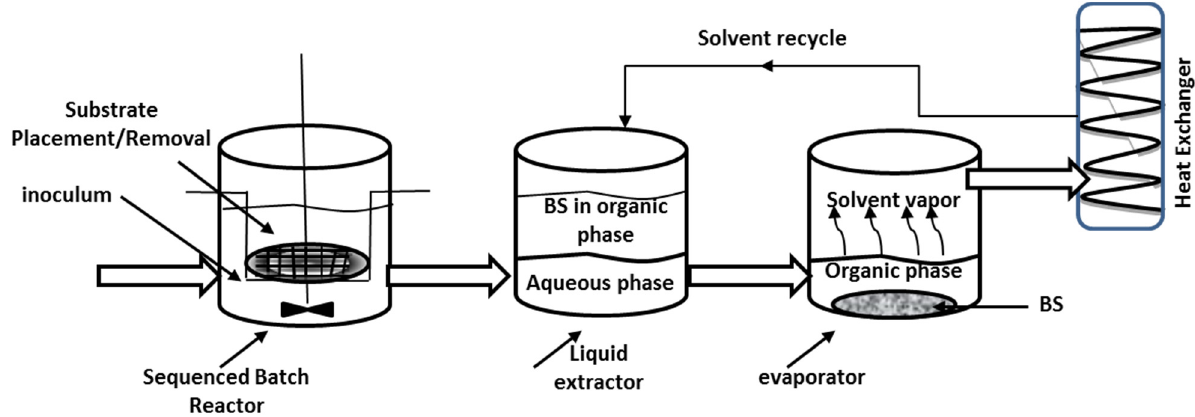
Figure A7. Bioremediation test results. Aromatic hydrocarbons concentration after 28 days of bio-